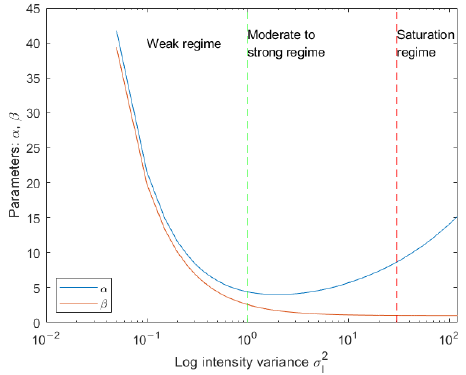
Figure 2. Values of α and β under different turbulence regimes: weak, moderate to strong, and saturation.